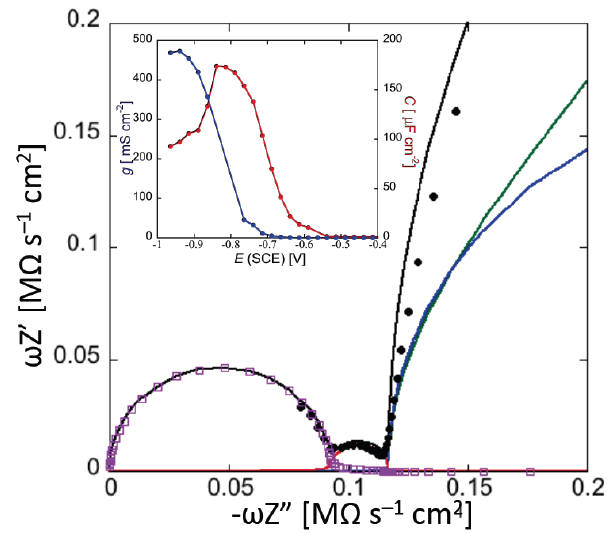
Figure 14. Plot of ωZ ′ (solid circles) against − ωZ ″ at a Hg-supported DPTL/DPhPC tBLM incorporating gramicidin from its 0.1 μM solution in aqueous 0.1 KCl at −0.675 V vs. SCE. The solid black curve is the best fit of this plot by an equivalent circuit consisting of a series of four RC meshes. The purple, red, blue and green curves are calculated contributions to ωZ ′ from the spacer moiety, the “inner layer” moiety, the lipid bilayer moiety and the aqueous solution adjacent to the BLM. The inset shows plots of conductance g (blue curve) and capacitance C (red curve) of the inner layer against E at the same tBLM. (Reproduced from [53] with permission from the Royal Society of Chemistry).